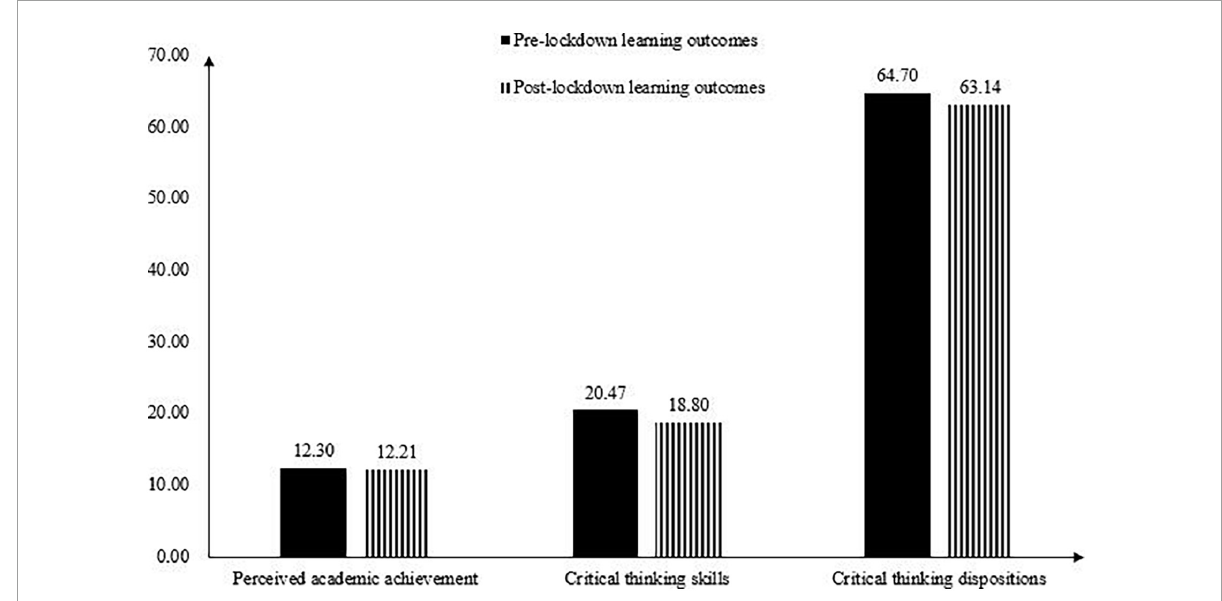
FIGURE1 Illustration the average performance for each learning outcome before and after the university lockdown.